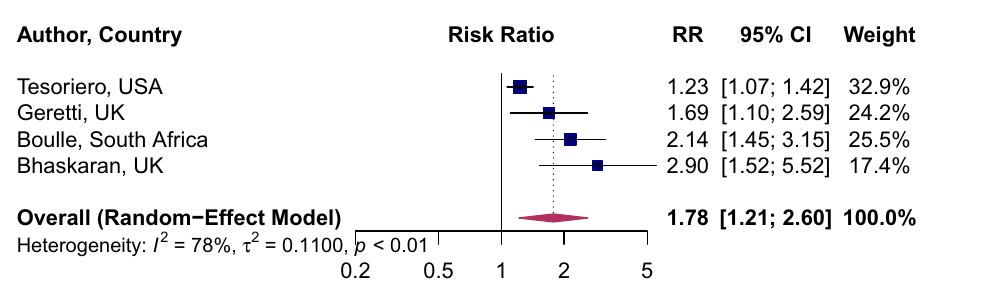
Figure 5. Association of HIV and mortality risk from COVID-19. Blue squares and their corresponding lines are the point estimates and 95% confidence intervals per each study. Maroon diamond represents the pooled effect